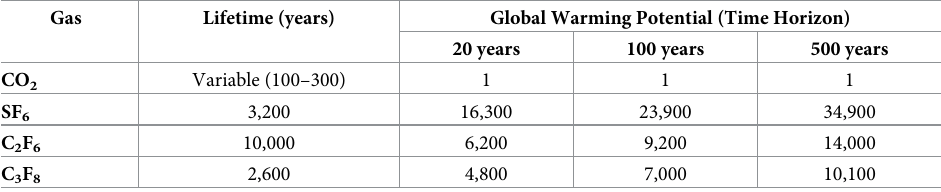
Table 1. Global Warming Potentials at different time periods.